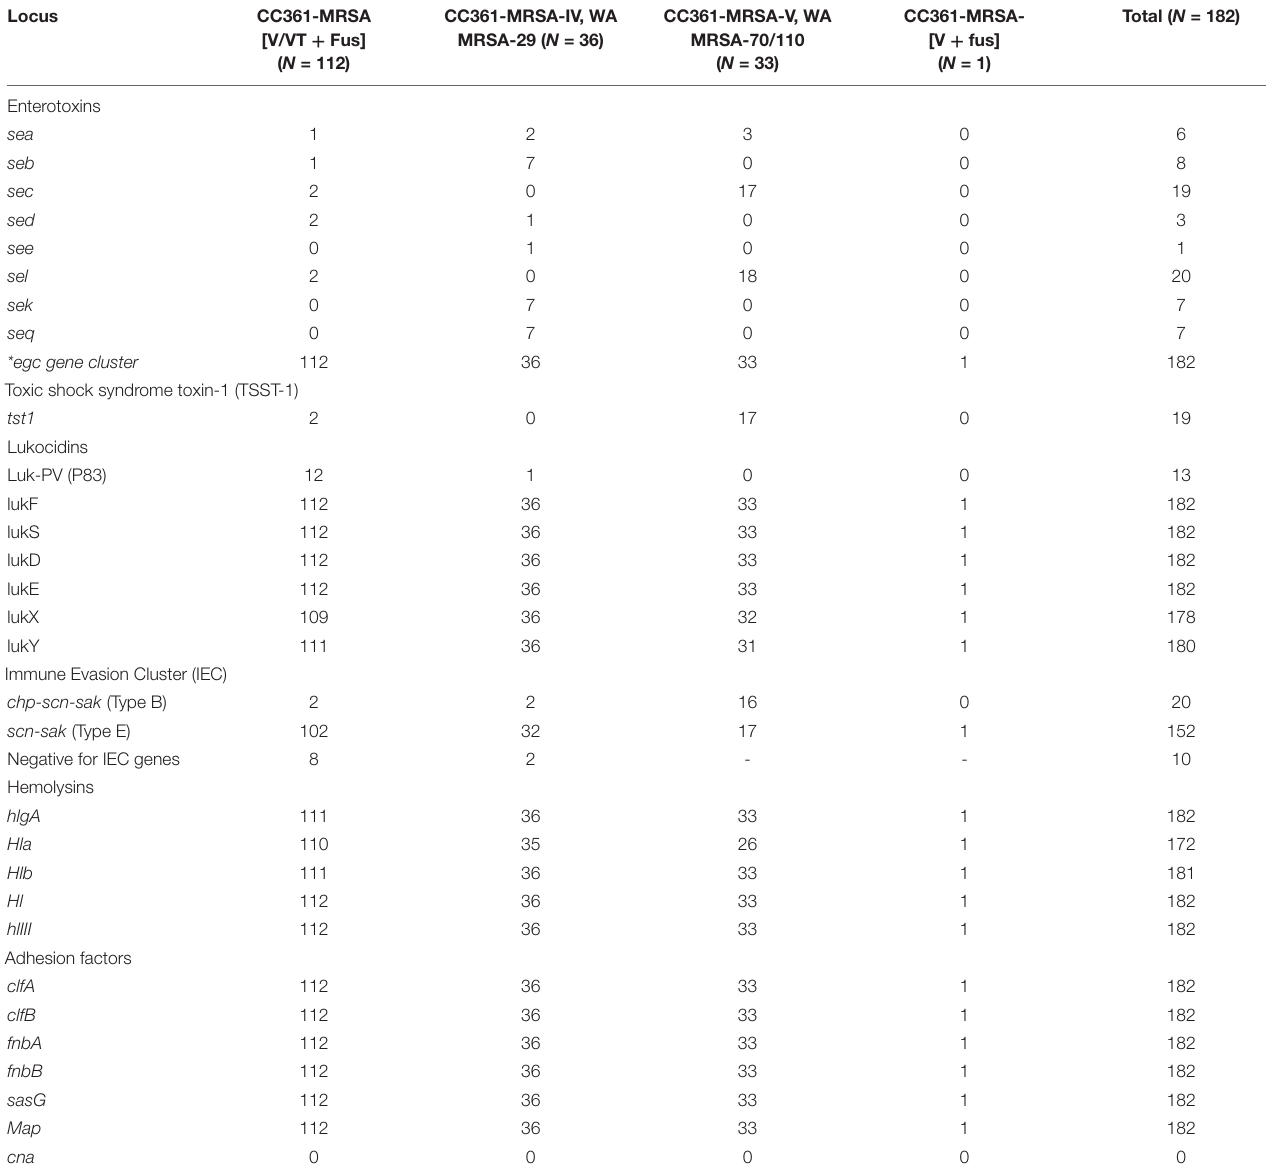
TABLE 3 | Virulence factors amongst the CC361-MRSA strains.